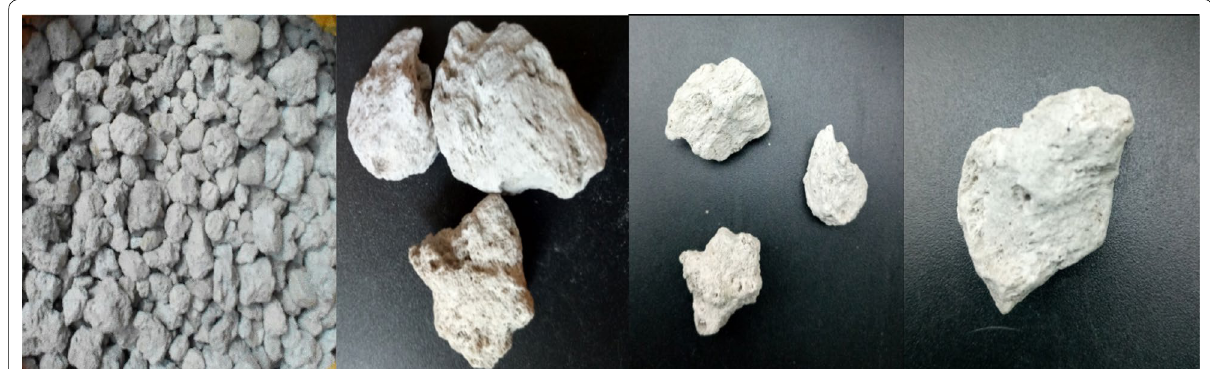
Fig. 1 Typical pumice: photograph Mekonnen Birhanie March/2016, Ethiopia